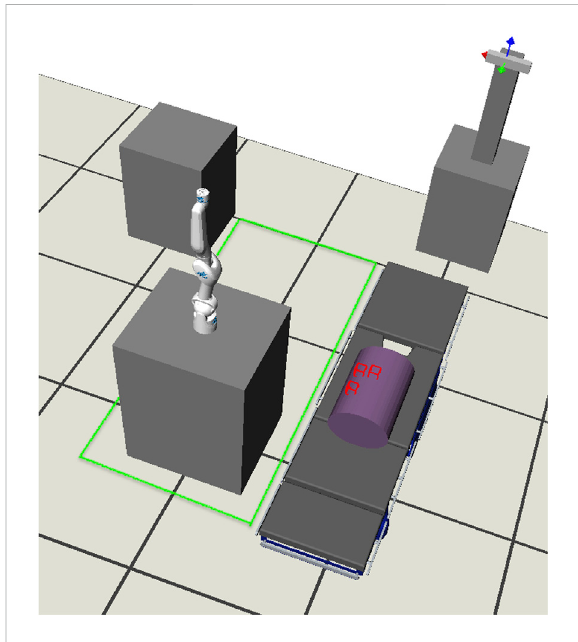
FIGURE 7 Pedicle screw placement positions (highlighted in red on the elliptical cylinder approximation of the patient ’ s spine region) and free region for the robot base (highlighted in green on the fl